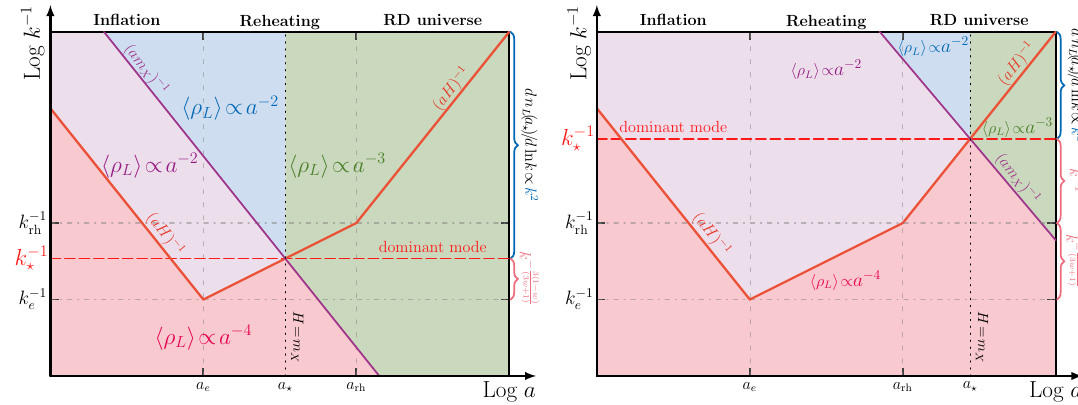
Figure 5 . Scaling of the energy density per ln k as a function of the scale factor a in various regions of the (log k (cid:0) 1 ; log a ) space for heavy vector DM i.e m X >H rh (left diagram) and light vector DM m X <H rh (right diagram). The main contribution to the total energy density comes from the mode k ? (cid:17) a ? m X . Here k e (cid:17) a e H e and k rh (cid:17) a rh H rh . Along the right sides of the panels we show scaling of number density per ln k at a = a ? w.r.t. mode momentum k